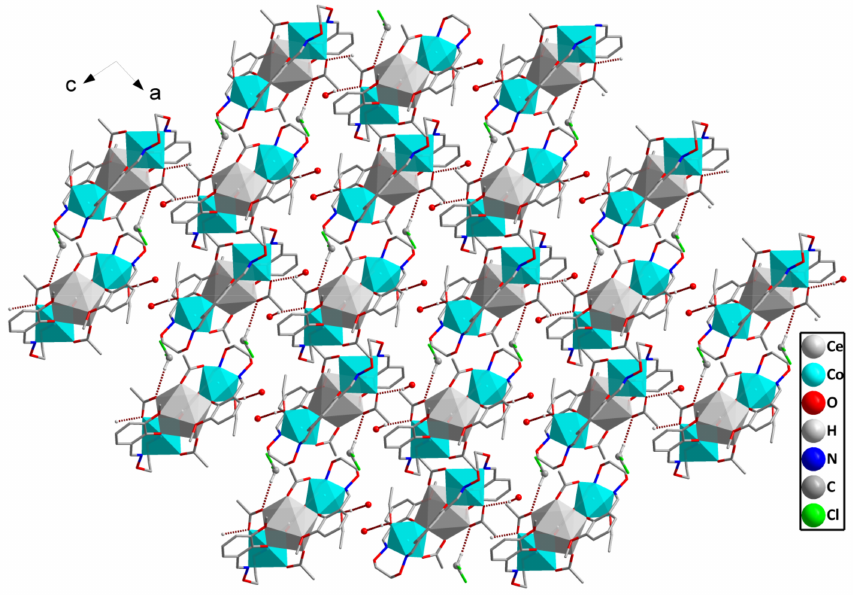
Figure 6. View of 2D supramolecular structure by the intermolecular O–H ··· O and C–H ··· O interactions of the Co(II)-Ce(III)